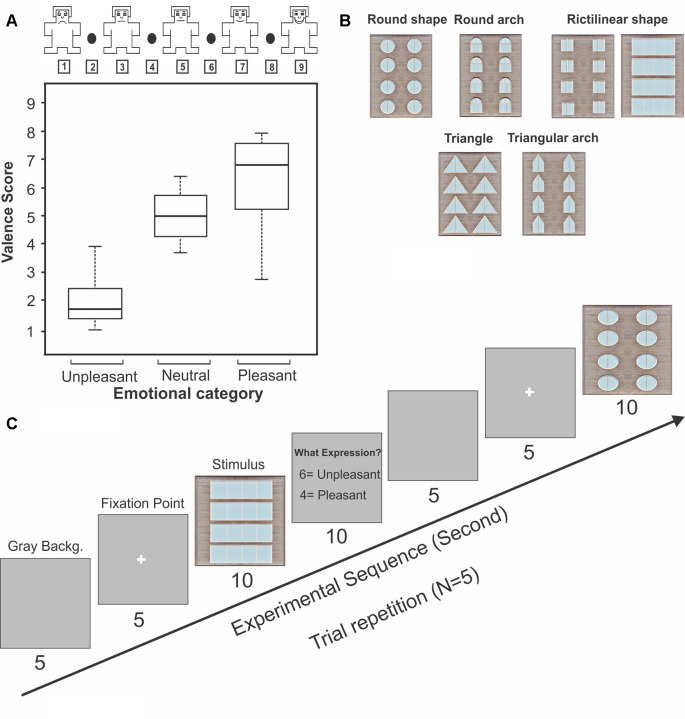
The Self-Assessment Manikin (SAM) rating test and experimental design for electroencephalogram (EEG) recording. Panel (A) represents the SAM rating of geometric windows as a function of the emotional categories. The box shows the upper and lower quartiles, the bar inside the box represents the median, and error bars indicate the variability outside the upper and lower quartiles. Panel (B) represents the sample of geometric window shapes. Panel (C) represents the experimental procedure for EEG recording setup.